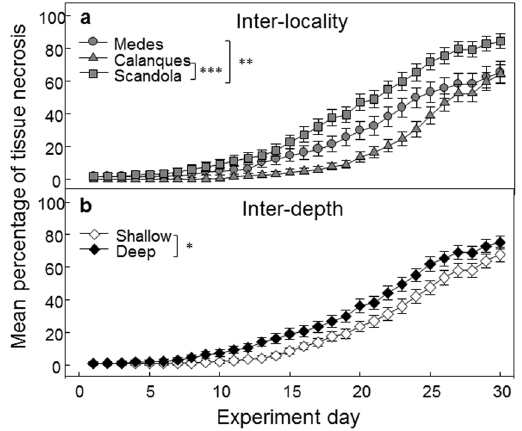
Figure 4. Results of the common garden experiment. Mean percentage ( ± SE) of tissue necrosis of colonies from the study localities ( a ) and depths ( b ) during the 25 °C experiment. The levels of significance of the differences between pairs of localities ( a ) and depths ( b ) from the two-way pairwise PERMANOVA are indicated as follows: *** p-value < 0.001, ** p-value < 0.01, * p-value < 0.05. The lack of indications between pairs denotes the absence of significant